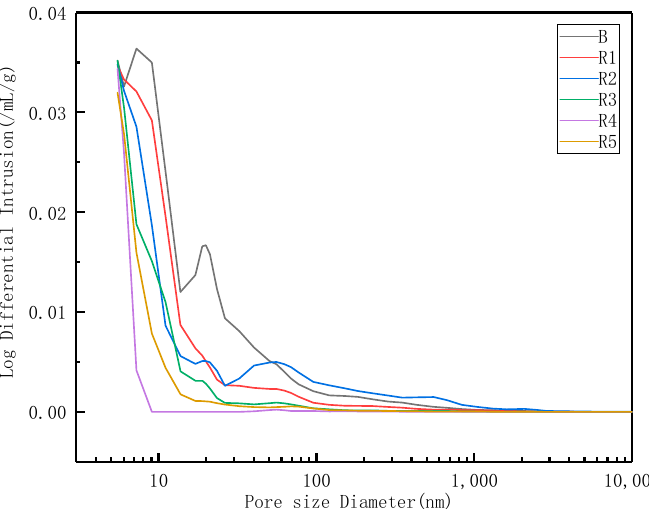
Figure 11. The pore size distribution of recycled brick powder UHPC under different substitution rates. Table 10. The pore structure parameters of recycled brick powder UHPC with different substitution rates.